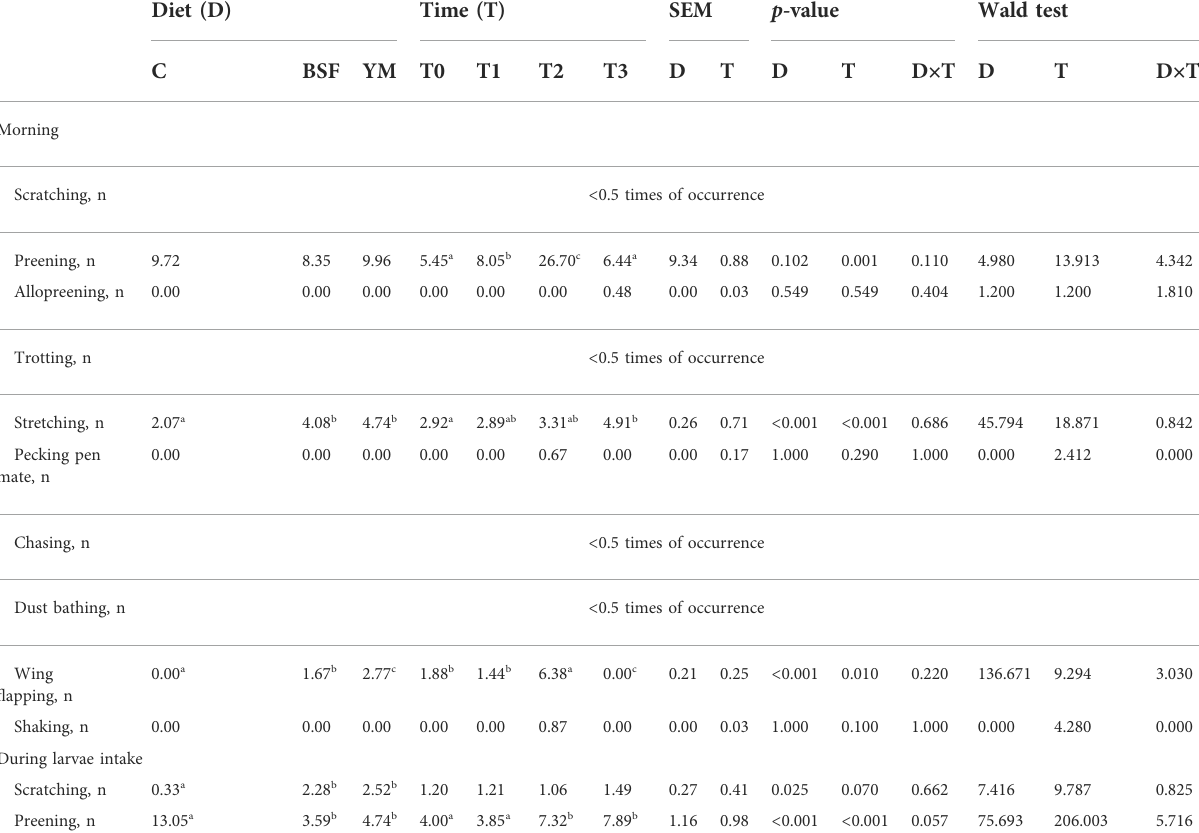
TABLE 3 Frequency behaviours of the broiler chickens depending on diet, time and their interaction. Diet (D) Time (T) SEM p -value Wald